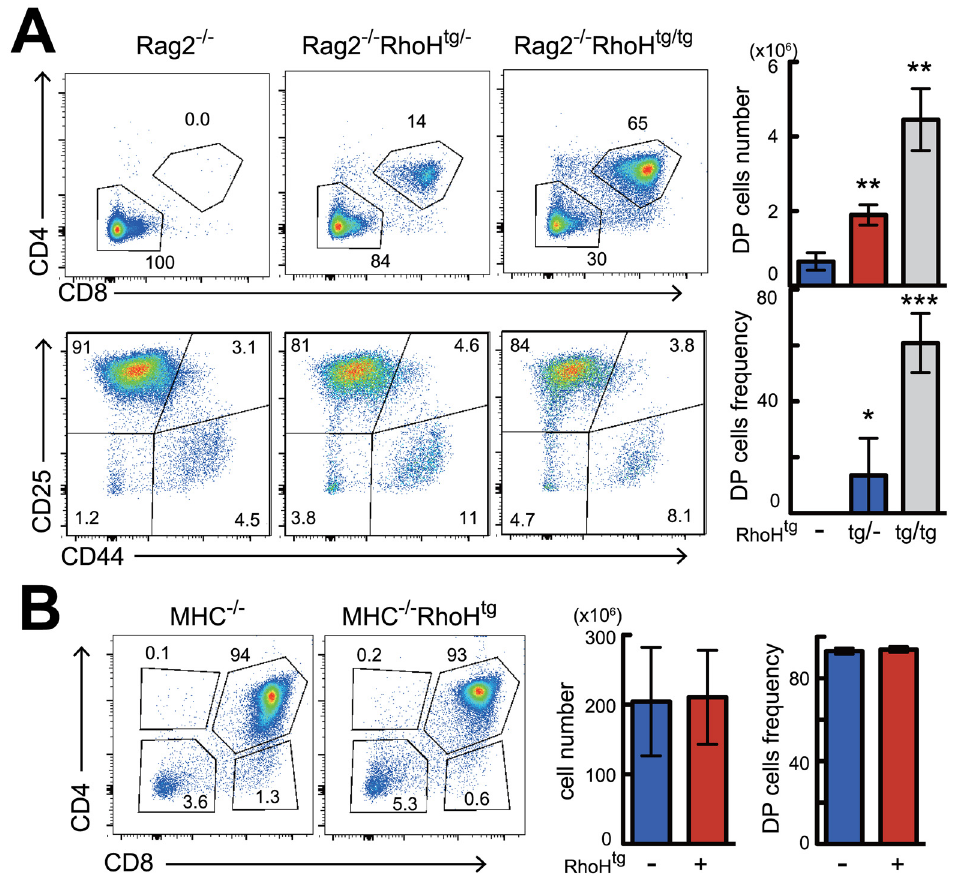
Fig 3. RhoH transgene expression enables transition from DN to DP stages in Rag2 -/- mice. FACS analysis of thymocyte differentiation in Rag2 -/- (A) or MHC -/- (B) background. Representative two parameter plots show CD4 versus CD8 staining on thymocytes and CD25 versus CD44 staining on DN cells. Bar graphs represent average cell number and frequency of indicated thymocyte subsets calculated from five mice per group. ** P < 0.01, *** P <